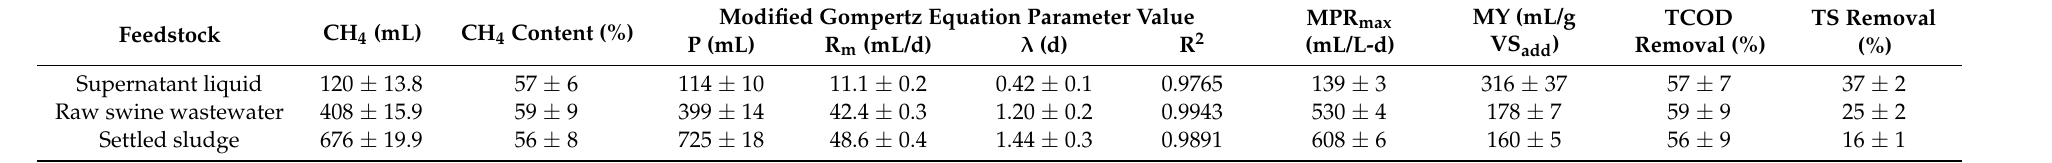
Table 1. Methane production and pollutant removal efficiency from various swine manure sources.